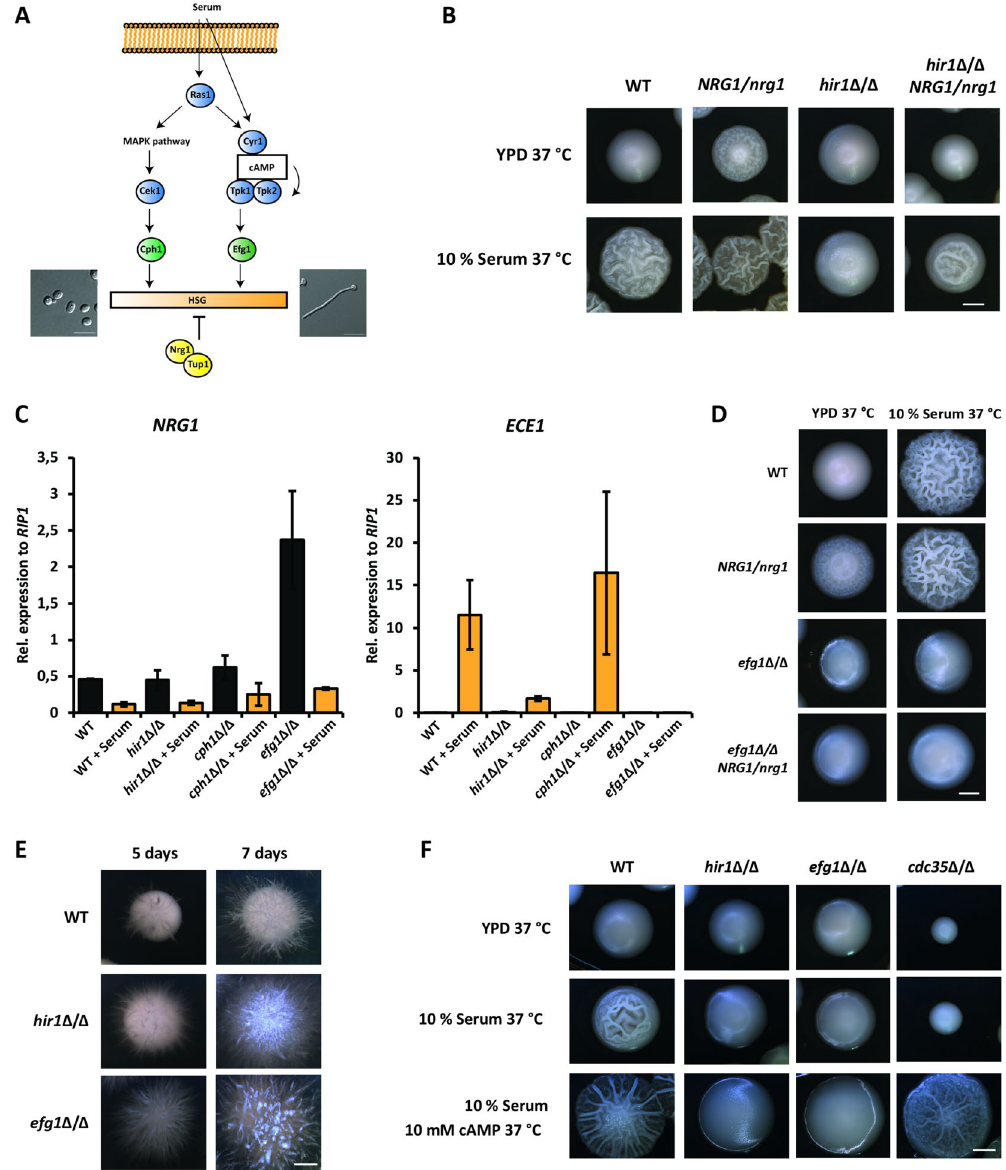
Figure 2. Loss of HIR1 phenocopies deletion of EFG1 . ( A ) Simplified scheme of the major signaling cascades regulating the hyphal transcriptional program. The MAPK cascade and the cAMP/PKA pathway activate transcription factors such as Efg1 and Cph1 to initiate HSG expression. Additionally, transcriptional repressors such as Nrg1 and Tup1 control HSG expression and are themselves regulated by upstream signaling cascades such as cAMP/PKA. ( B ) Reduction in NRG1 gene dosage alleviates hyphal formation defects of hir1 Δ / Δ cells on solid medium. Colony morphology was inspected after 3 days at 37 °C. Scale bar corresponds to 1 mm. ( C ) NRG1 downregulation is independent of EFG1 , CPH1 and HIR1 . Gene expression of NRG1 and ECE1 was measured after 30 min of hyphal induction in YPD with 10% FCS by RT-qPCR. Transcript levels were normalized to the expression of the reference gene RIP1 . Data are presented as mean + SD of three independent experiments. ( D ) Reduction of NRG1 gene dosage does not affect efg1 ∆ / ∆ hyphal formation. Colony morphology was assessed after 3 days at 37 °C. Scale bar corresponds to 1 mm. ( E ) Loss of HIR1 partially phenocopies efg1 Δ / Δ under embedded growth conditions. Colony pictures were taken after 5 and 7 days at 25 °C. Scale bar corresponds to 1 mm. ( F ) HIR1 mutant cells are irresponsive to exogenous cAMP supplementation. Colony morphology was assessed after 3 days at 37 °C. Scale bar corresponds to 1